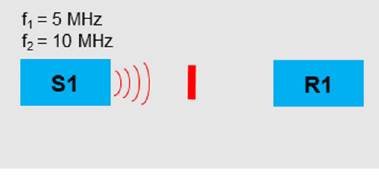
Figure 3. Sensor arrangement—evidence signal grouping.